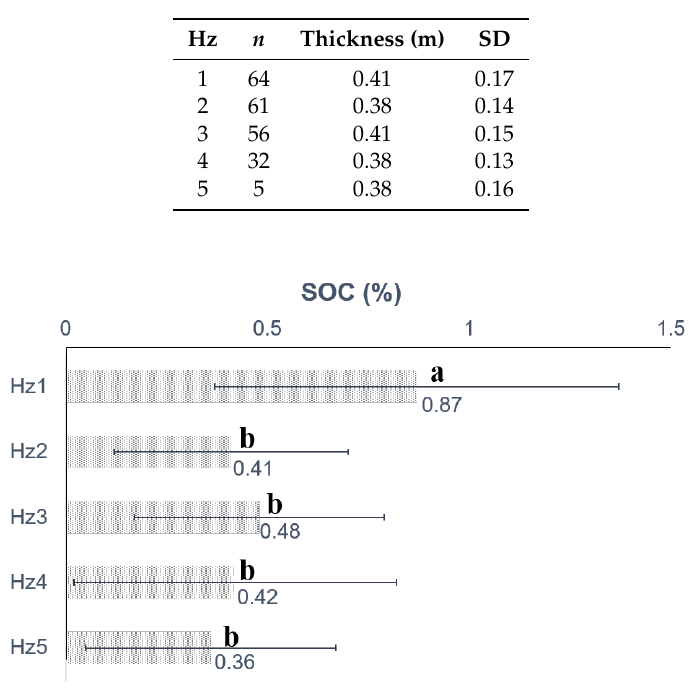
Table 2. Average thickness in each horizon (Hz); standard deviation (SD).